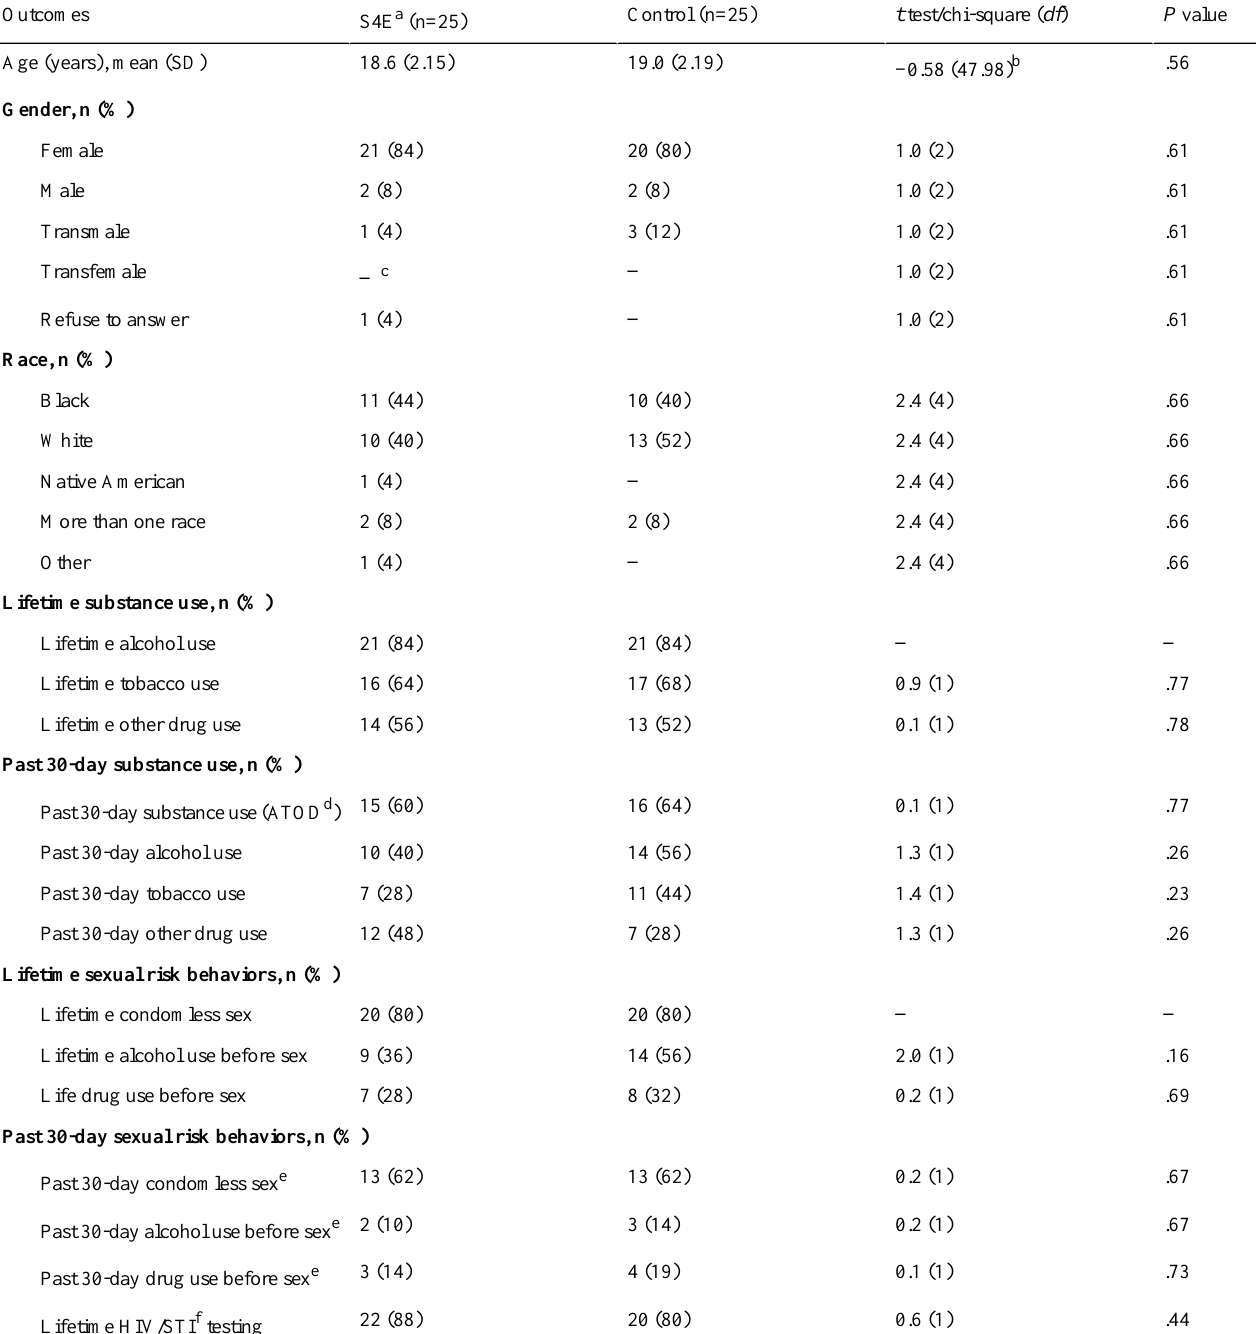
Table 1. Baseline comparisons by group on demographic and behavioral outcomes